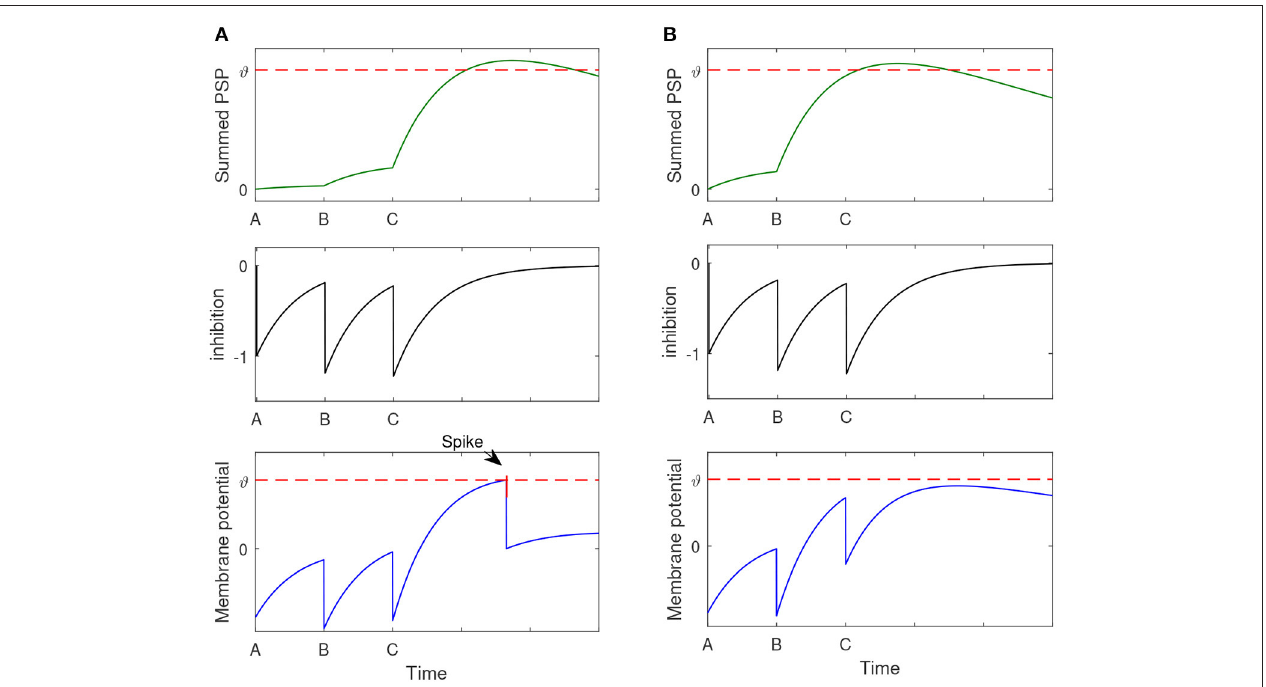
FIGURE 5 | The process of sequence retrieval. The memory model has stored two sentences: A-B-C-D and A-B-E-F . When the context A-B-C is presented, the memory model can successfully recall A-B-C-D and it will not retrieve the sequence A-B-E-F . (A) The membrane potential dynamics of neuron “D.” (B) The membrane potential dynamics of neuron “E” .